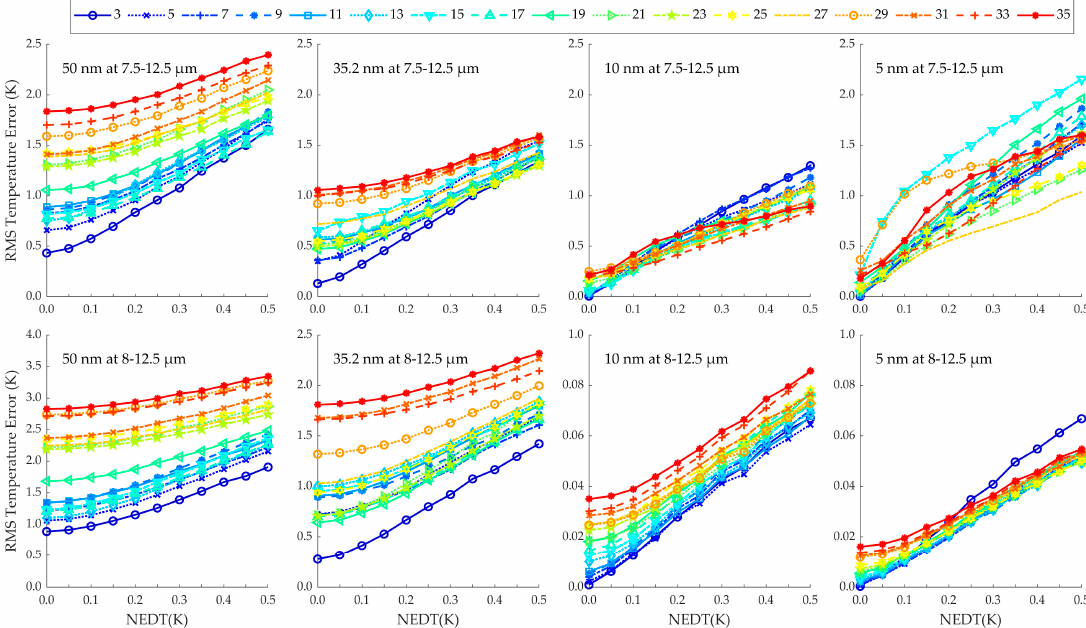
Figure 11 . The retrieved LST errors of RDSS under different window size settings. Figure 11. The retrieved LST errors of RDSS under di ff erent window size